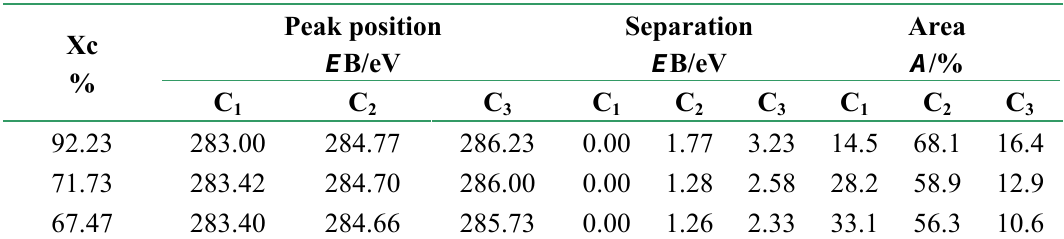
XPS datum of MCC with different crystalline degree. Table 4. The C 1s